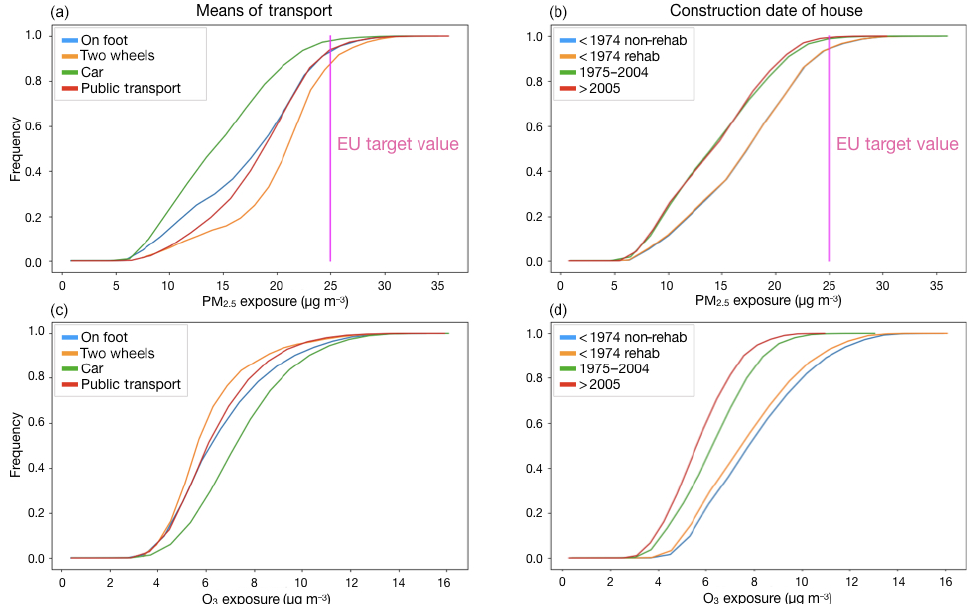
Figure 11. Cumulative distributions of exposure to PM 2 . 5 (a, b) and O 3 (c, d) for subpopulations distinguished by the transportation mode (a, c) and construction date of the building where they live (b, d) .